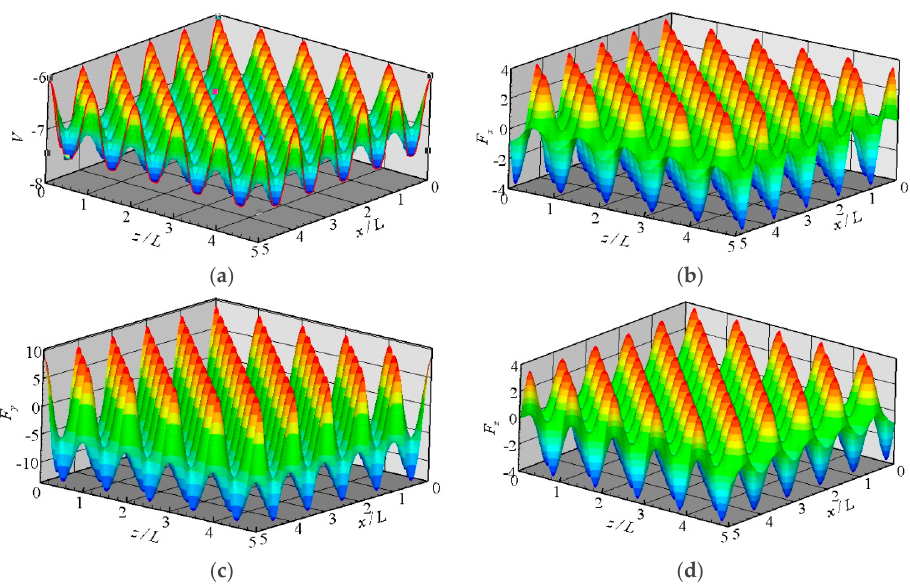
Figure 2. Distributions of the potential and forces at the plane y = 0.3405 nm above the wall surface, ( a ) potential; ( b ) F x ; ( c ) F y ; and ( d ) F z .